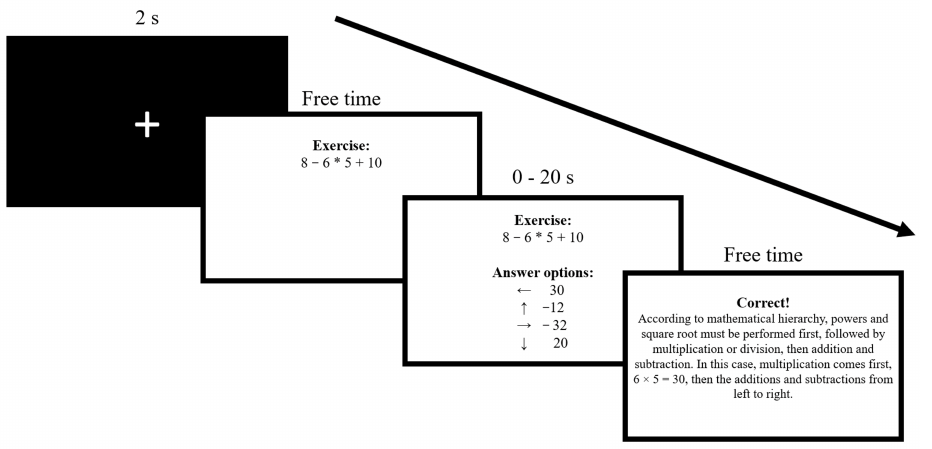
Figure 3. Task structure in the case of correct responses. Structure of the presentation of the mathe- matical approaches to the proof when a correct answer was